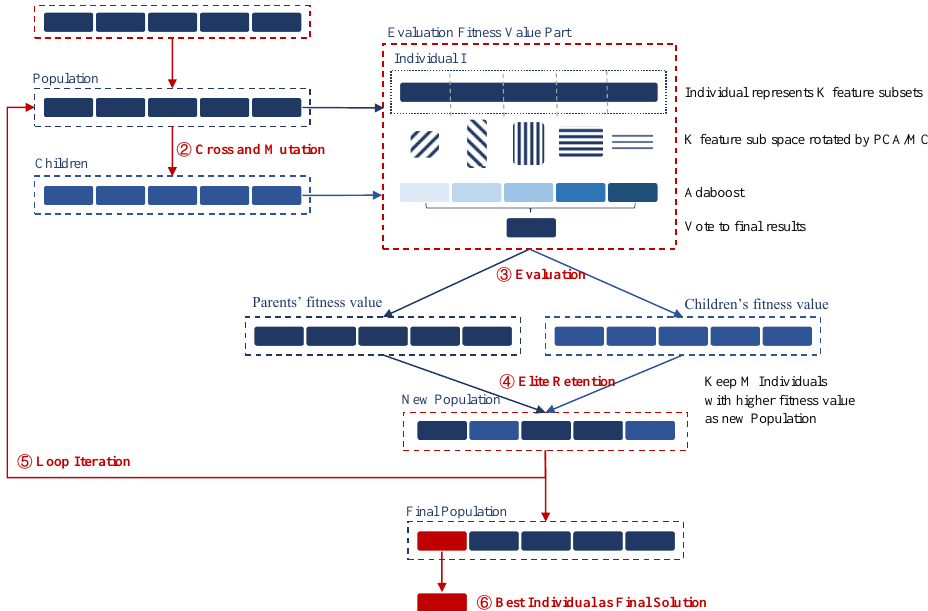
Figure 2. The overall framework of R-E-GA. The steps in red fonts ① – ⑥ indicate the sequence flow of our algorithm, the blue fonts represent the objects and elements operated by the algorithm, and the black fonts represent some descriptions of the operation.